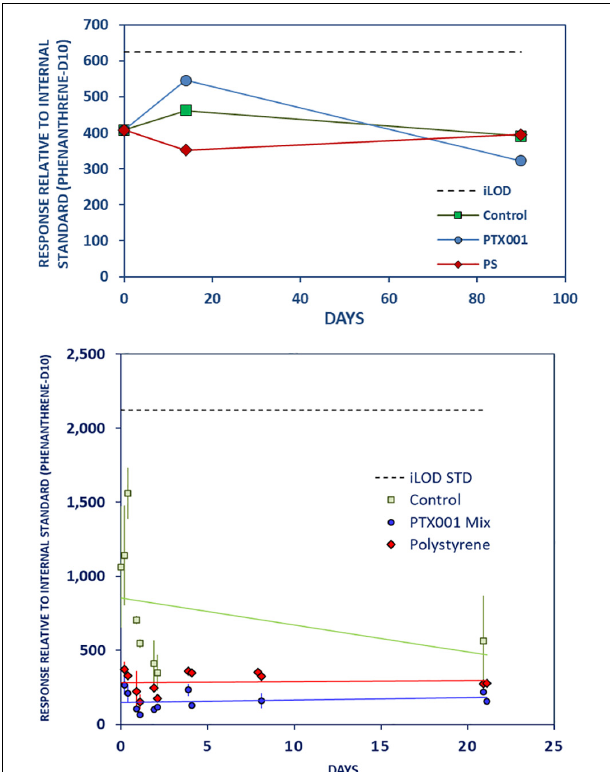
FIGURE 8 | No leaching of triphenylbenzene from PTX001 or PS to stomach oil. Further caption details as in Figure 2